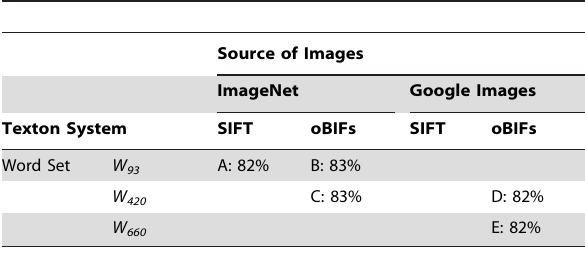
Table 1. Effect on performance of image source and texton system